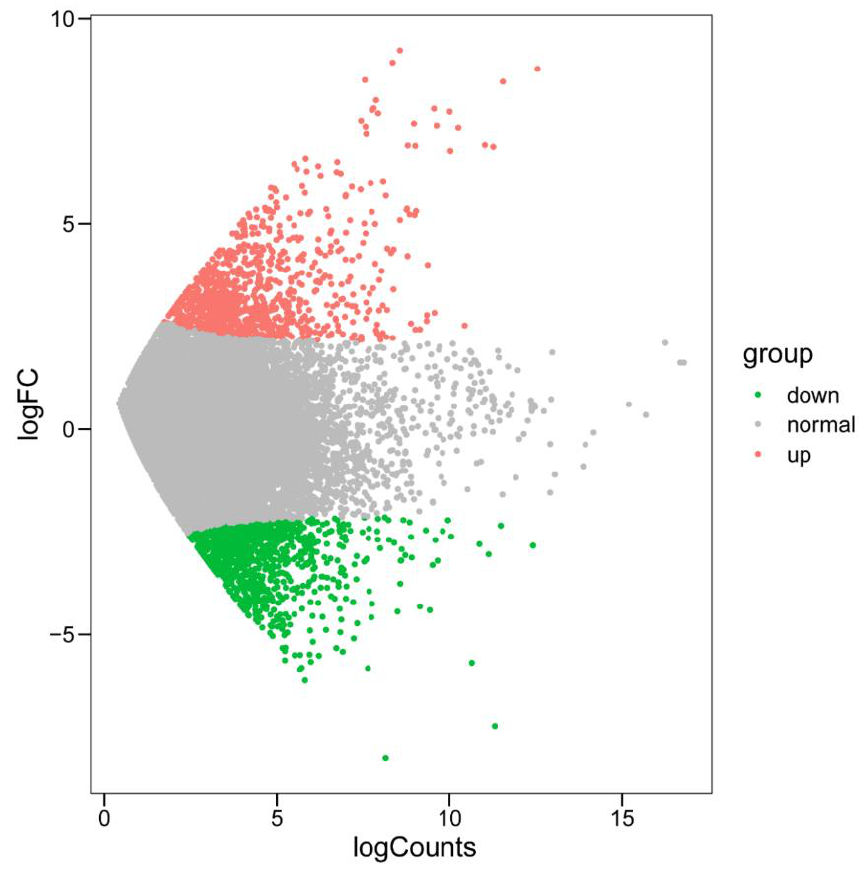
Figure 1. MA plot showing differentially expressed genes.